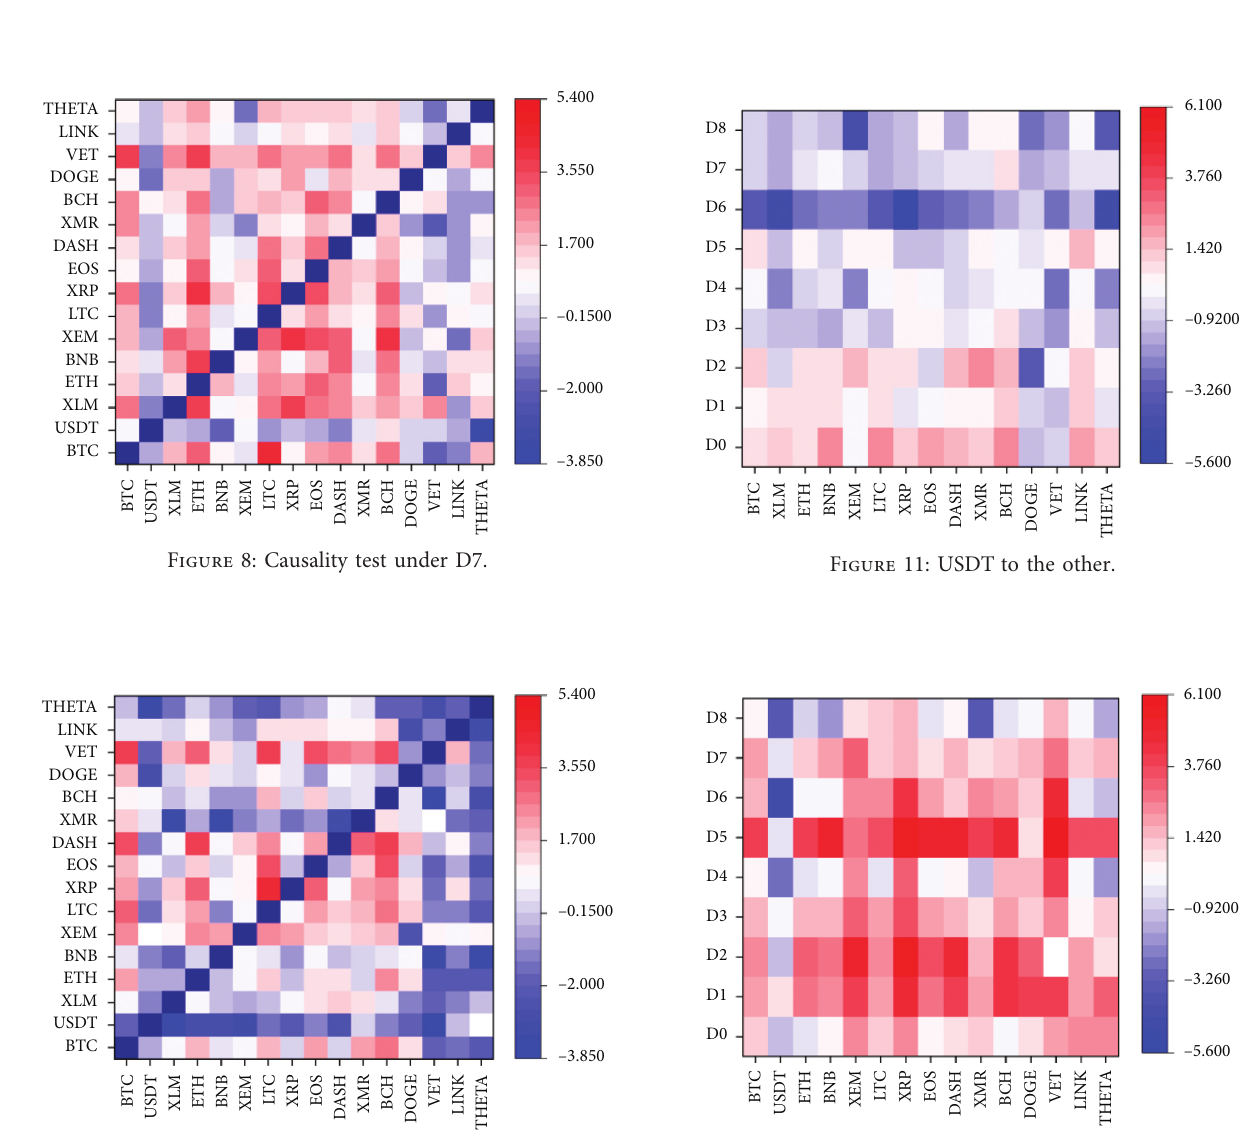
Figure 12: XLM to the